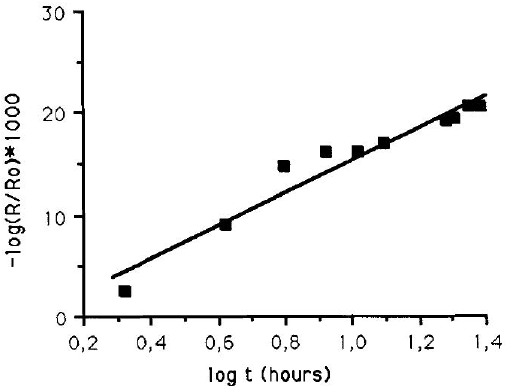
Figure 1. The infrared absorbance of the cuprite peak at 645 cm − 1 as a function of exposure time when a copper surface was exposed to 90% RH, revealing a logarithmic oxide growth. Reproduced by permission of [28], The Electrochemical Society. Copyright